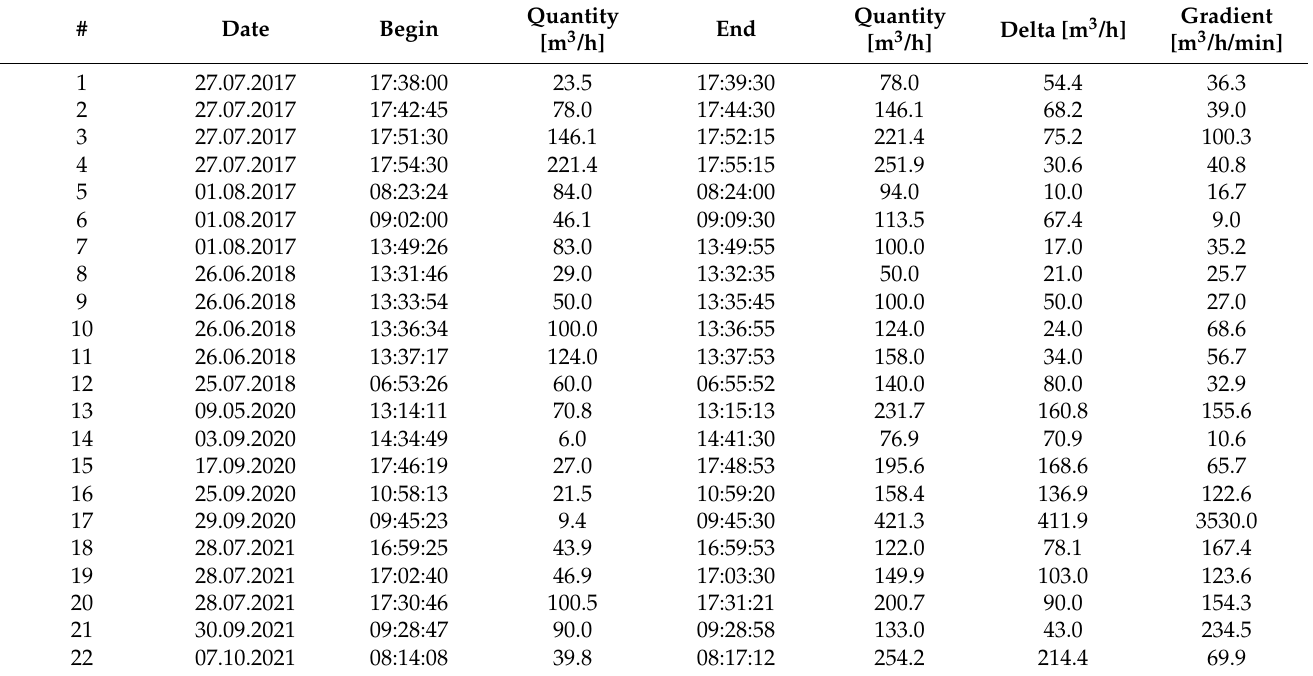
Table 1. Evaluation of 22 real